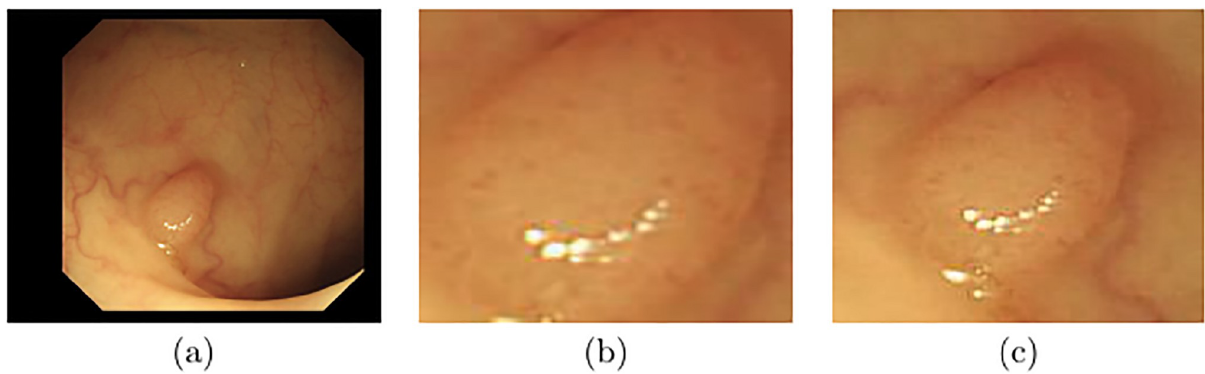
Fig 2. Type of polyp input: Same polyp frame with different versions of input. (a) Full frame, where the actual polyp feature is less compare to its background features. (b) The cropped polyp. (c) The cropped polyp with around 55% of background. We generate data set-1 using (b) and set-2 using (c) in this